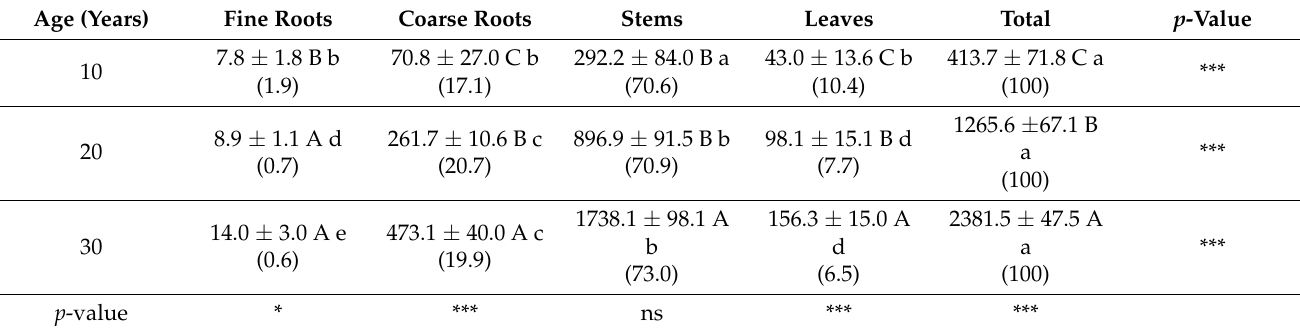
Table 1. Biomass (dry weight, kg ha − 1 ) and allocation (%) of fine roots, coarse roots, stems and leaves of different aged Chinese fir. The uppercase letters on the bars indicate significant difference between different aged trees of the same organs, while the lowercase letters indicate significant difference among organs in trees with same age. *, ***, and ns were indicated p < 0.05, p < 0.001, and no significance,